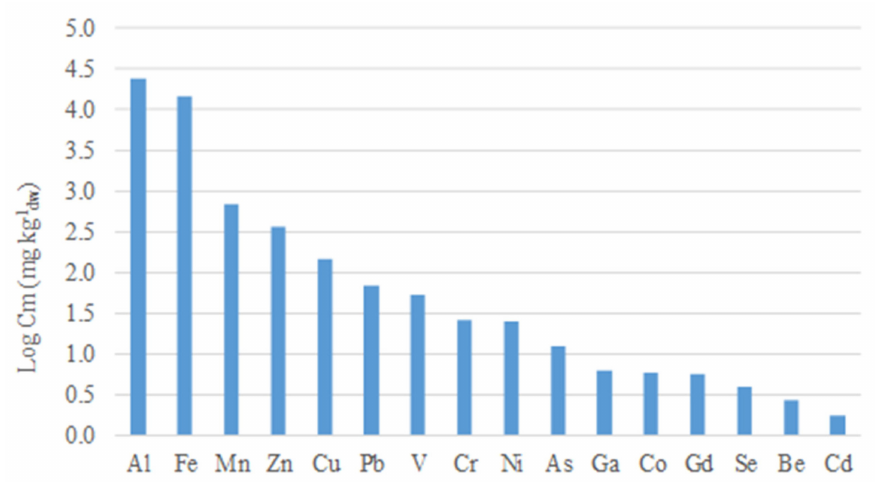
Figure 1. Average total concentrations (log Cm, mg kg − 1 ) of heavy metals and metalloids in raw waste activated sludge used in this study.